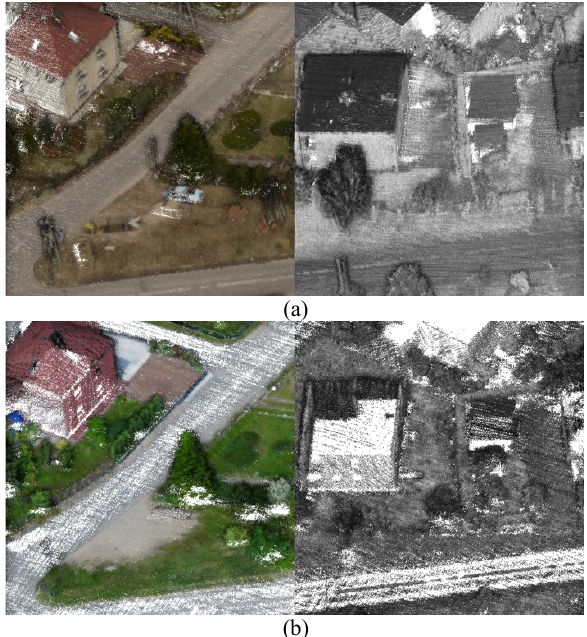
Figure 4 . Part of UAS LiDAR point cloud collected in 2018 (a), and in 2019 (b). Left – colorized by RGB data. Right – shown in greyscale intensities.